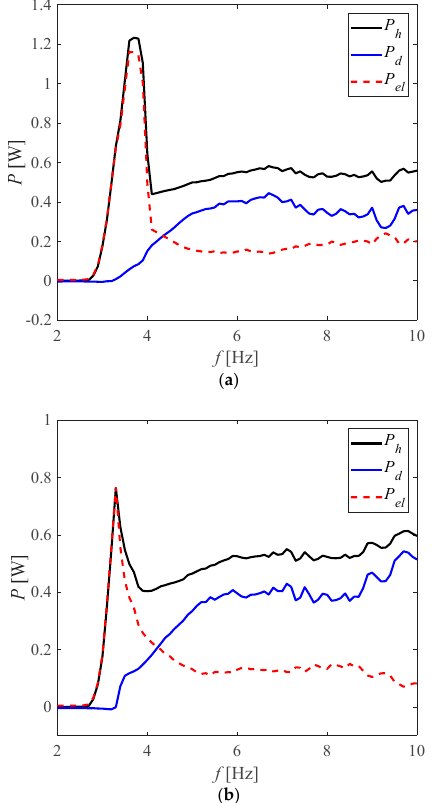
Figure 11. Powers P h , P d , P el vs. frequency f : ( a ) ECU N.O. version; ( b ) ECU N.C. version.